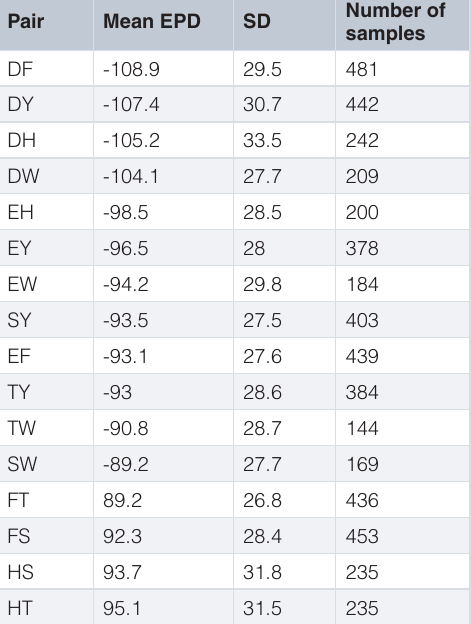
Table 3. Electrostatic potential differences (EPD) in a sample of consecutive residue pairs of C β atoms. These pairs are used for discriminating predicted structures in order to obtain the native structure. The complete set is available at https://